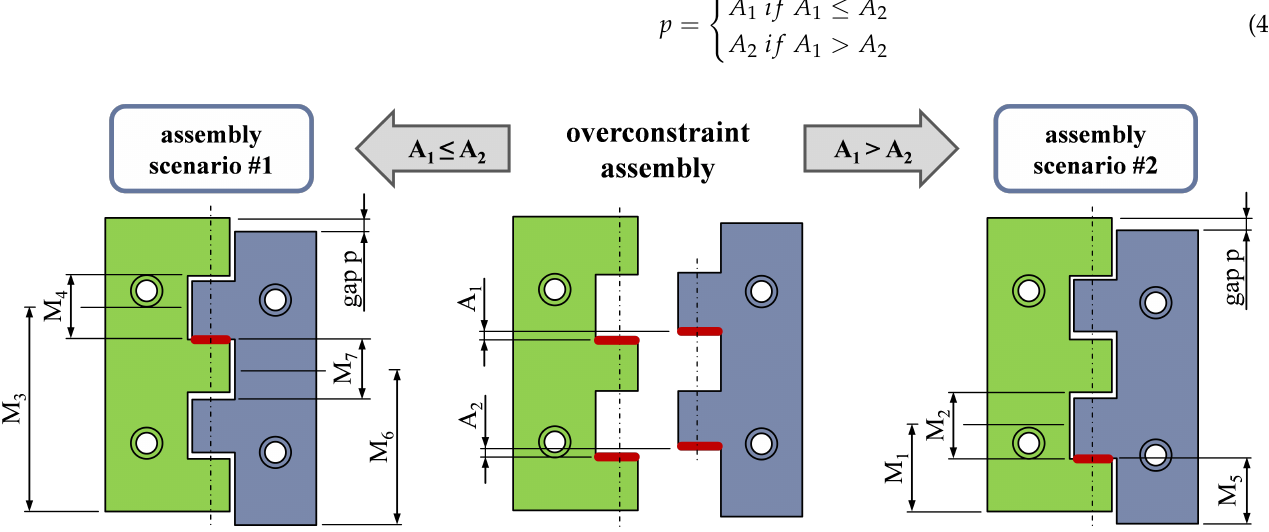
Figure 3. Two assembly scenarios occurring due to the overconstraint design of the door hinge